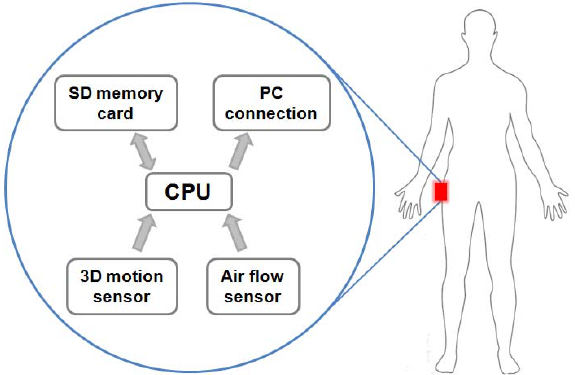
Figure 1. Scheme of the activity monitor used to measure acceleration and near-body air